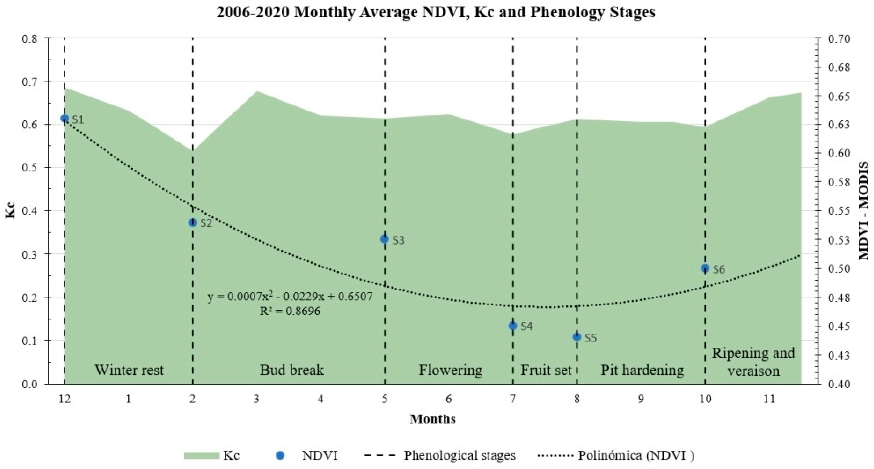
Figure 8. Relationship among NDVI, K c and phenological stages (Kc and NDVI are dimensionless).